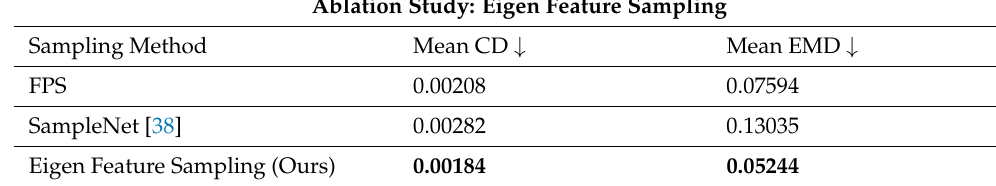
Table 3. Comparison of the proposed sampling method against FPS and SampleNet learned sampling. Lower is better.